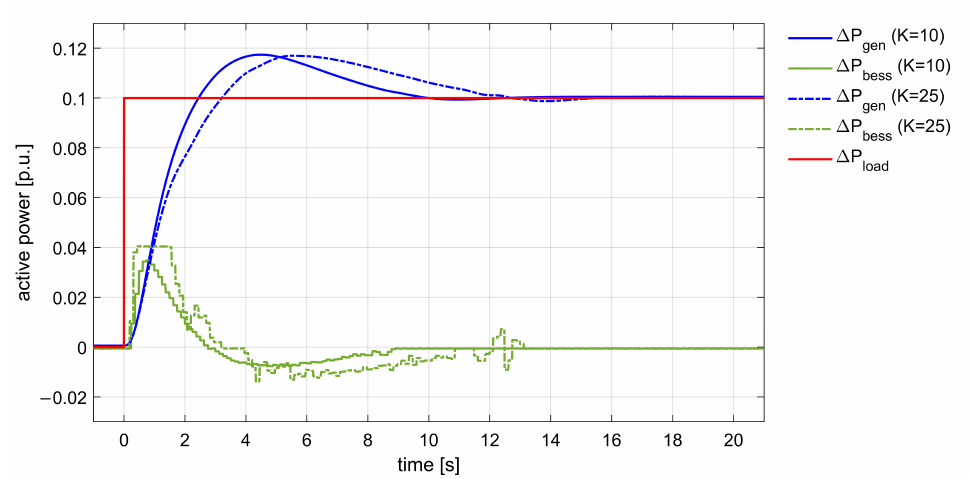
Figure 15. Real controller: BESS active power response with different gain K . Table 3. Real synthetic inertia controller: characteristics of the frequency step